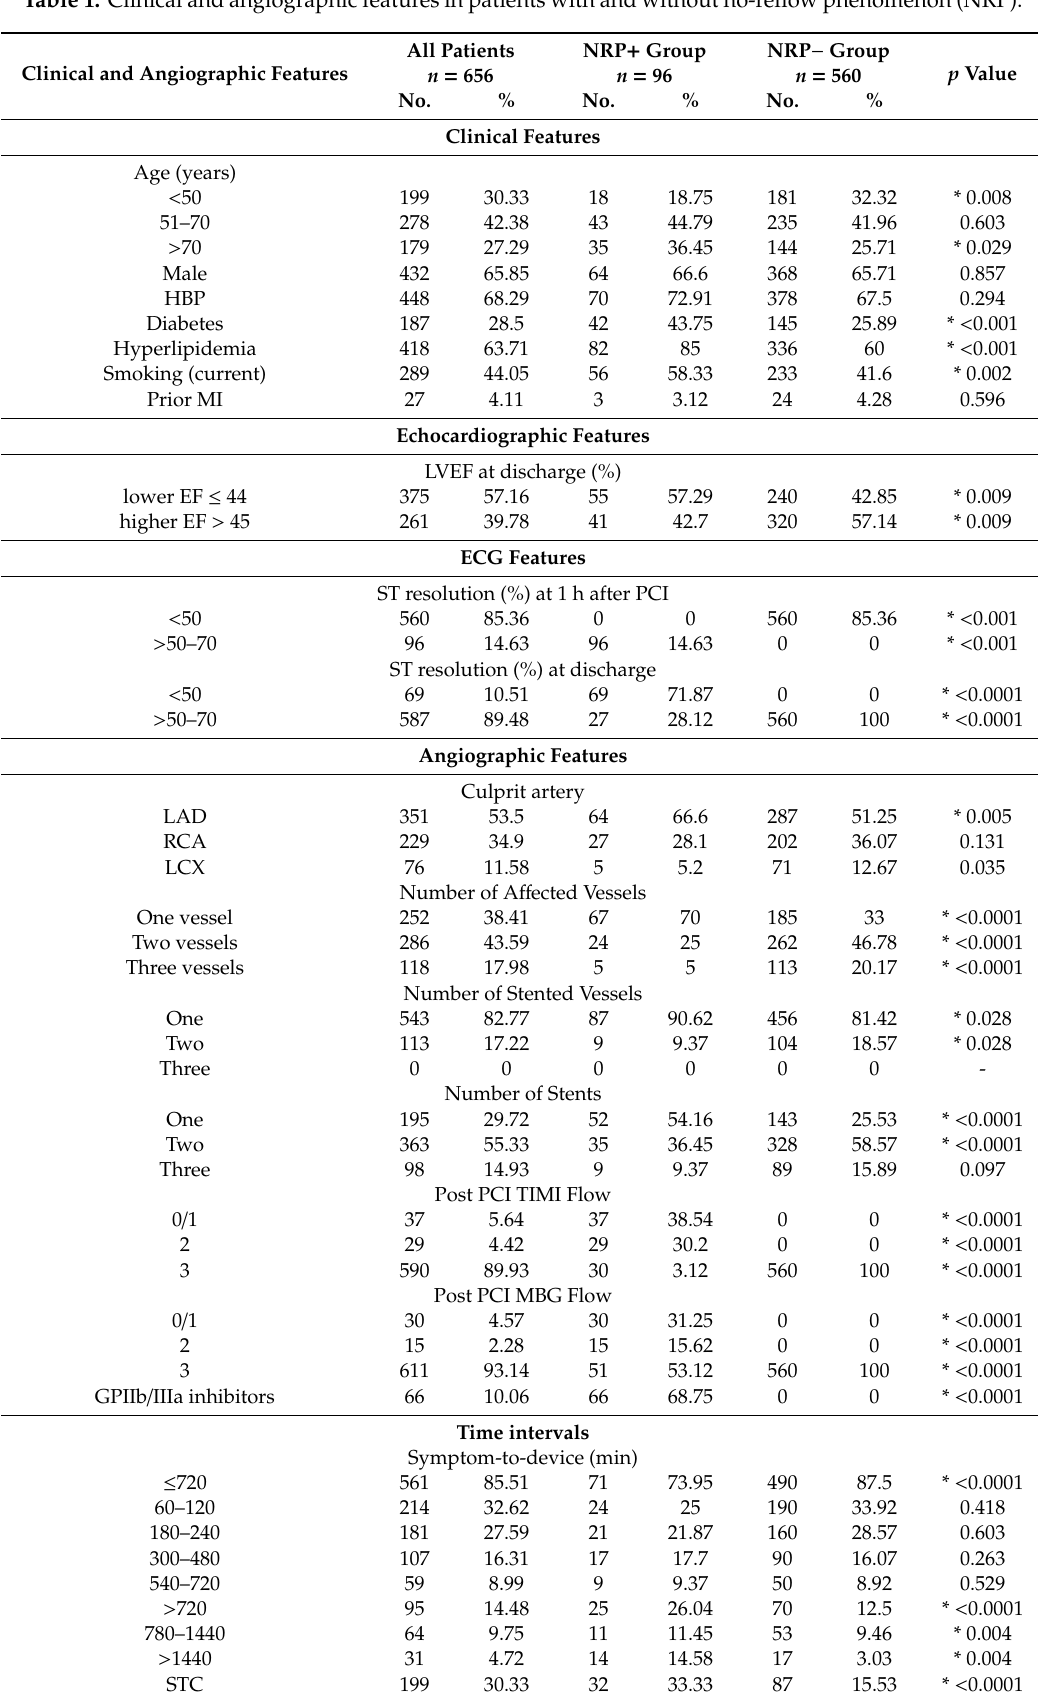
Table 1. Clinical and angiographic features in patients with and without no-reflow phenomenon (NRP). Clinical and Angiographic